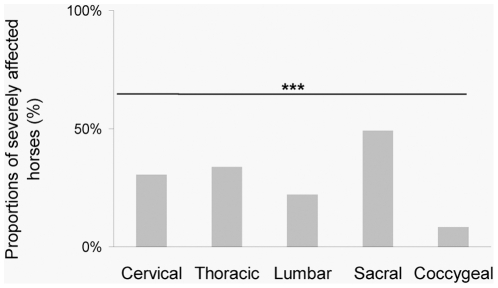
Proportions of severely affected horses in relation to vertebral area.The sacral area appeared affected in more horses than the other areas, followed by the thoracic area. Cochran test, *** p<0.001.